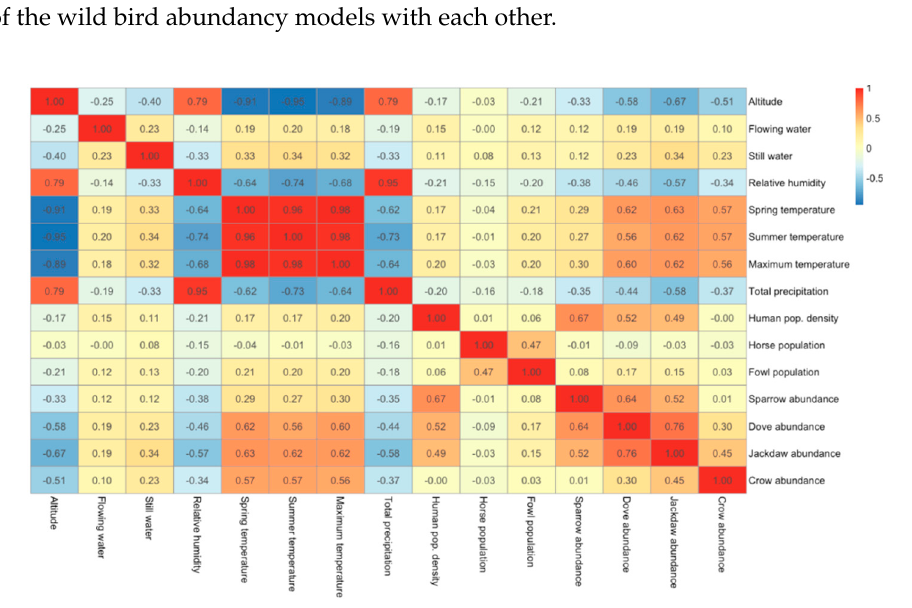
Figure 6. Spearman’s rank correlation coefficient between the cumulative presence 2015–2019 [0–5] and the predictors.